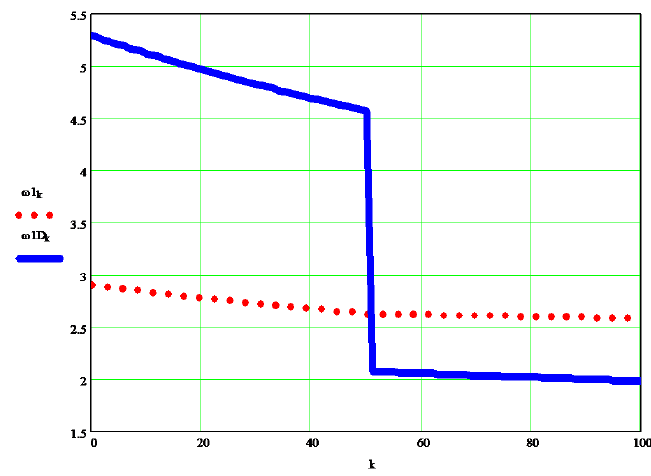
Figure 16. The dynamic angular speed of element 1 of the articulated robot, compared to the input (kinematics) considered speed (to a 6R2T robot).